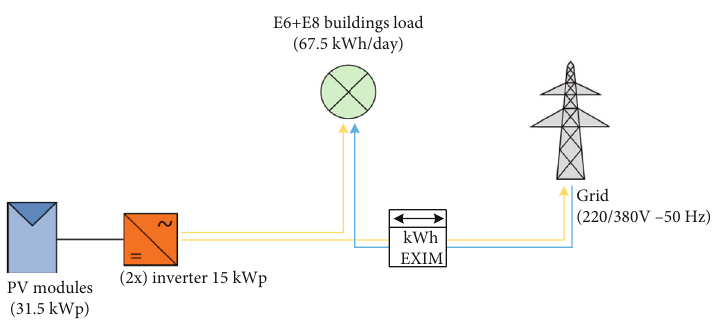
Figure 5: Scheme of BAPV connected to the grid for E6+E8 Buildings as scenario 2. Table 1: Modules PV used of design BAPV system.